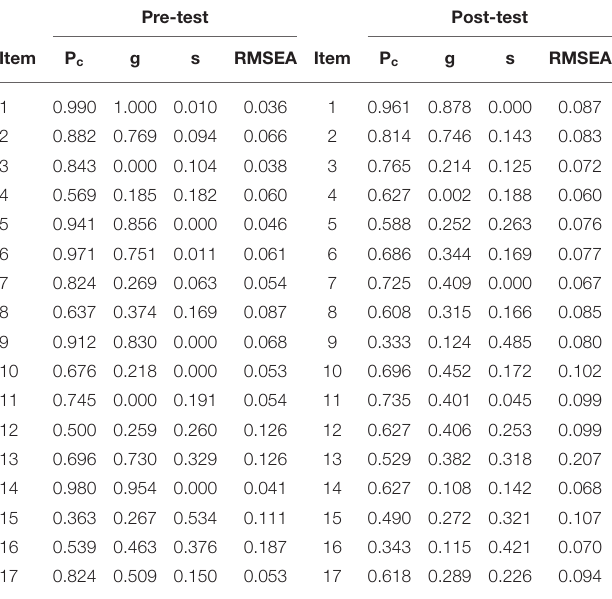
TABLE 7 | Item information.